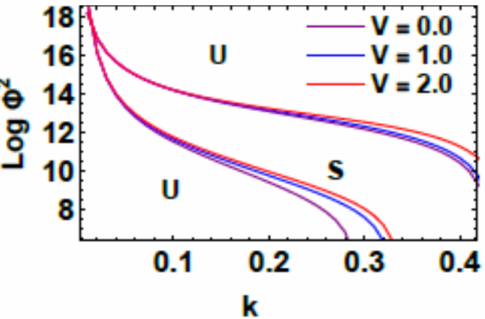
Figure 20. Variation of Log Φ 2 with k to depict the contribution of Equations (53) and (54) along with data A for different values the parameter V